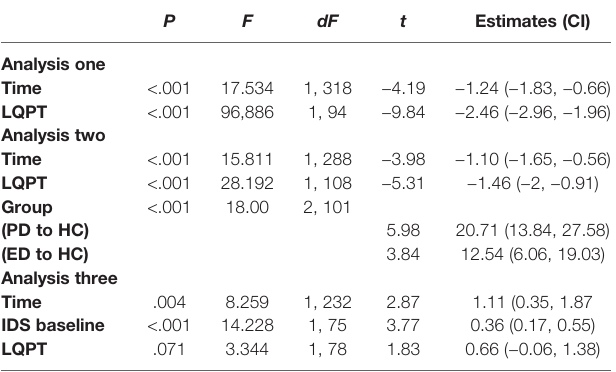
TABLE 2 | Results of linear mixed model analyses.